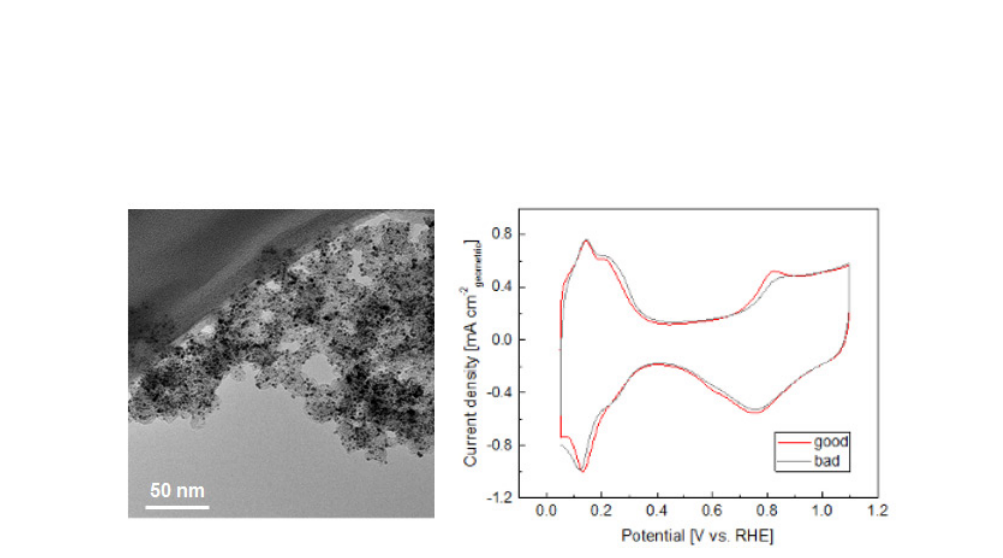
Fig. 8. – Left: Transmission Electron Microscopy (TEM) images of platinum nanoparticles on “Vulcan” carbon. Right: Representative examples for voltammograms for this catalyst (“good” and “bad” refer to well-cleaned and insufficiently cleaned samples, which is reflected in the sharpness of the distinct features). Images adapted from